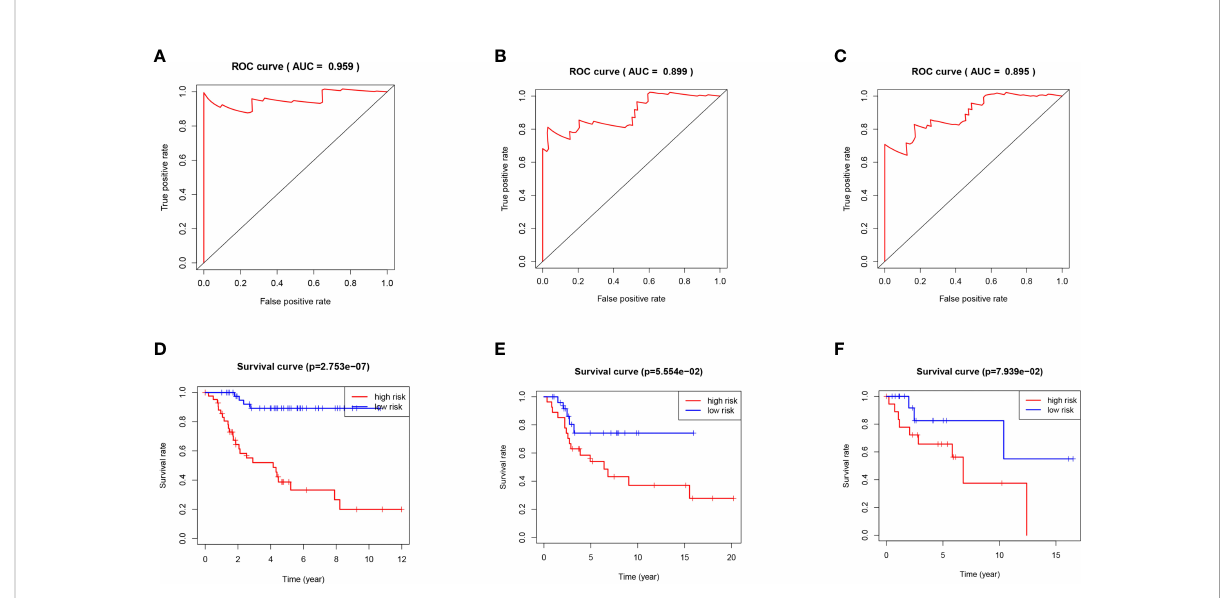
FIGURE 4 (A) ROC curve analysis of 1 year survival in TARGET patients with OS. (B) ROC curve analysis of 3 years survival in TARGET patients with OS. (C) ROC curve analysis of 5 years survival in TARGET patients with OS. (D) K-M curve of TARGET patients with OS. (E) K-M curve of GSE21257 patients with OS. (F) K-M curve of GSE39055 patients with